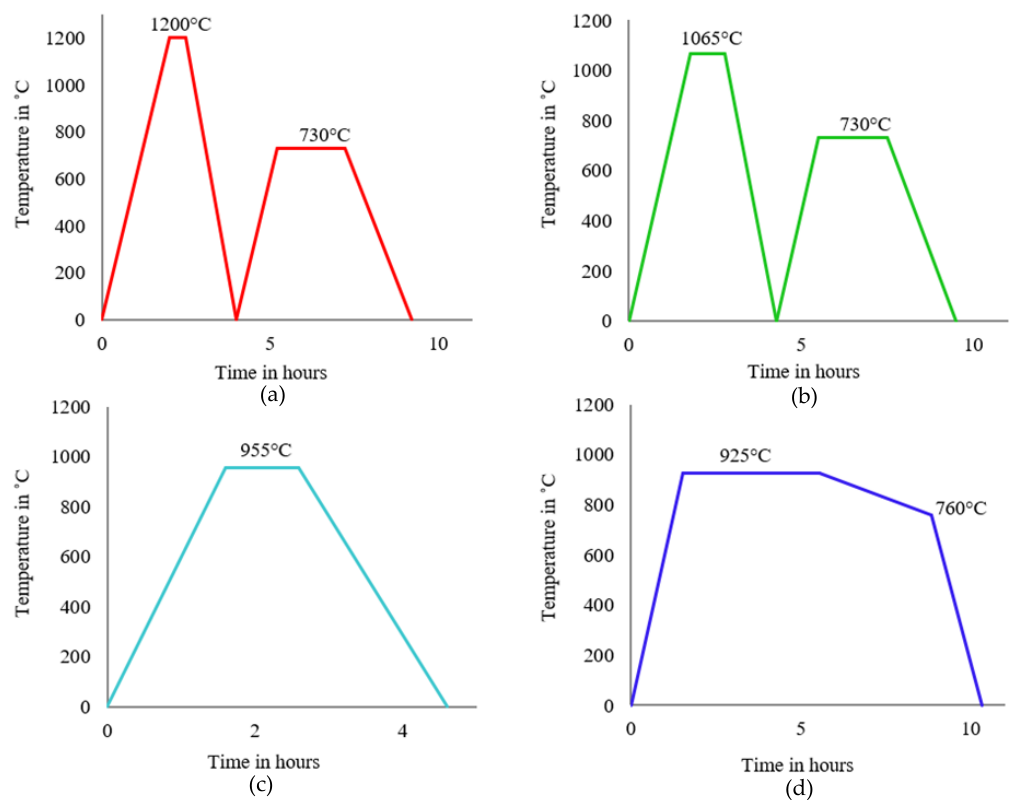
Figure 1. Schematic showing time-temperature cycles for annealing treatments ( a ) 1200 ◦ C / 30 min, FC, 730 ◦ C / 2 h; ( b ) 1065 ◦ C / 1 h, FC, 730 ◦ C / 2 h; ( c ) 955 ◦ C / 1 h, FC; ( d ) 925 ◦ C / 4 h, CFC@50 ◦ C / h to 760 ◦